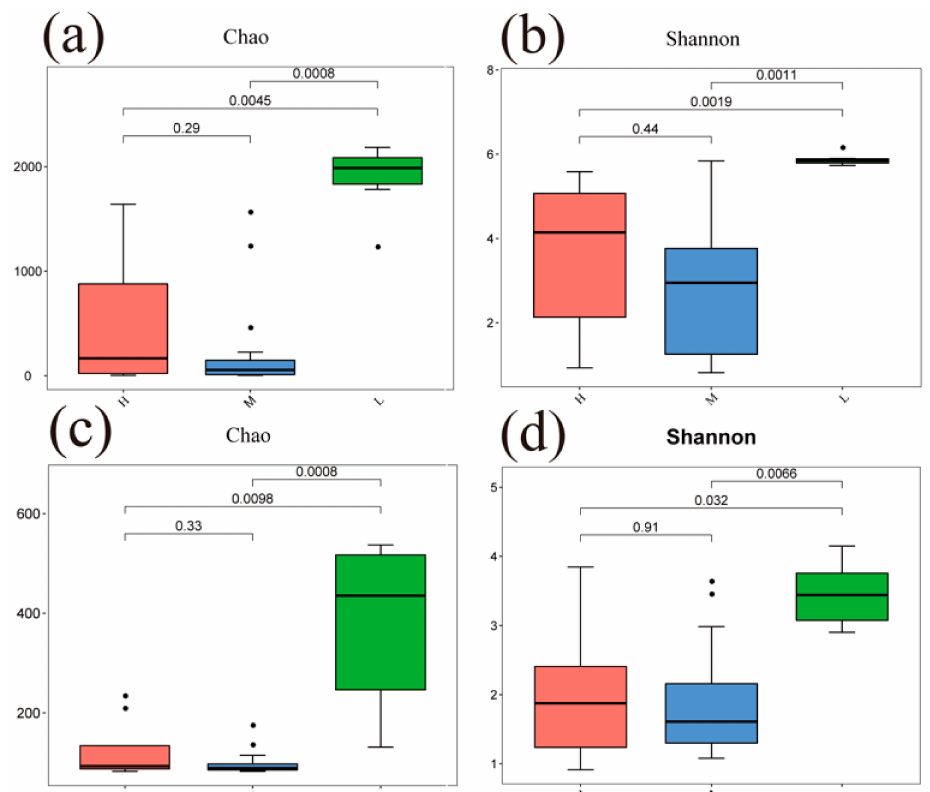
Figure 4. Alpha diversity of soil microorganisms under different water-salt gradients. Note: H, M and L denote high, medium and low water-salt gradients, respectively; ( a , b ) indicate the distribution of bacterial communities α -diversity among different water-salt gradients; ( c , d ) indicate the distribution of fungal communities α -diversity among different water-salt gradients.